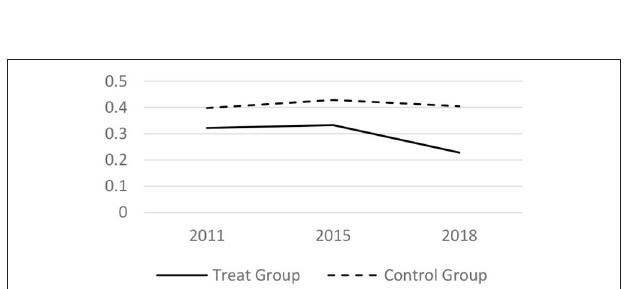
FIGURE 5 | Parallel trend of ADL score.